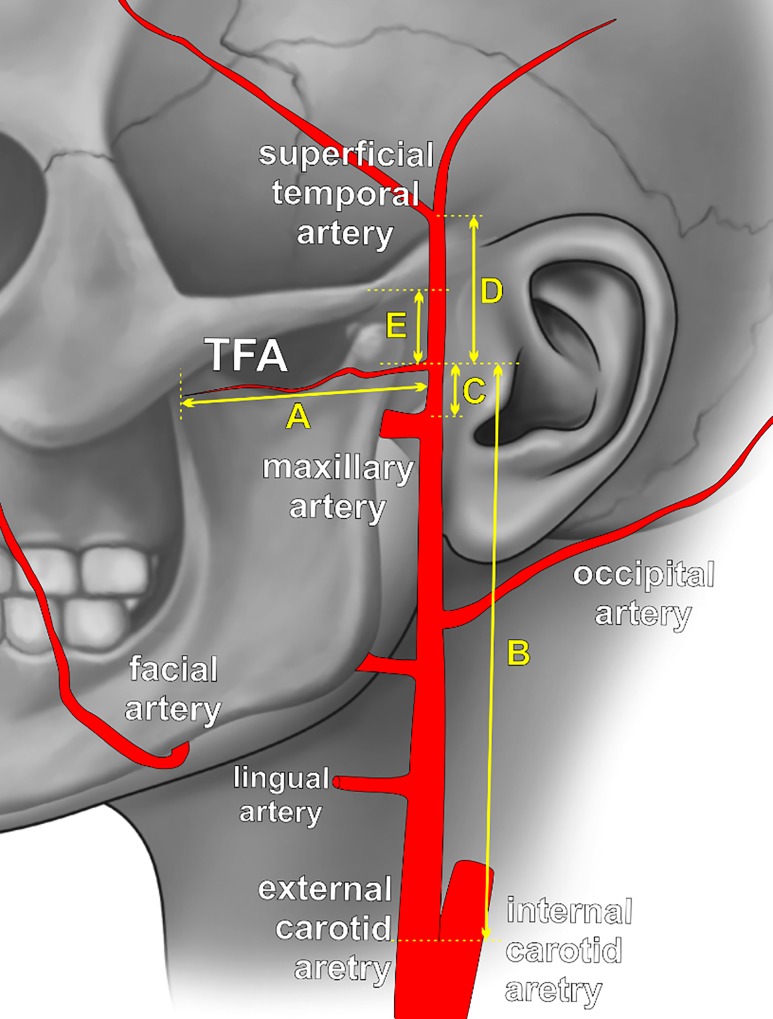
Schematic view of the external carotid artery tree with marked measurements points.A—the length of transverse facial artery (TFA), measured on its course; B—distance between the TFA origin and bifurcation of common carotid artery; C—distance between the TFA origin and bifurcation of external carotid artery; D—distance between the TFA origin and superficial temporal artery bifurcation; E—distance between the TFA origin and lower border of the zygomatic arch.